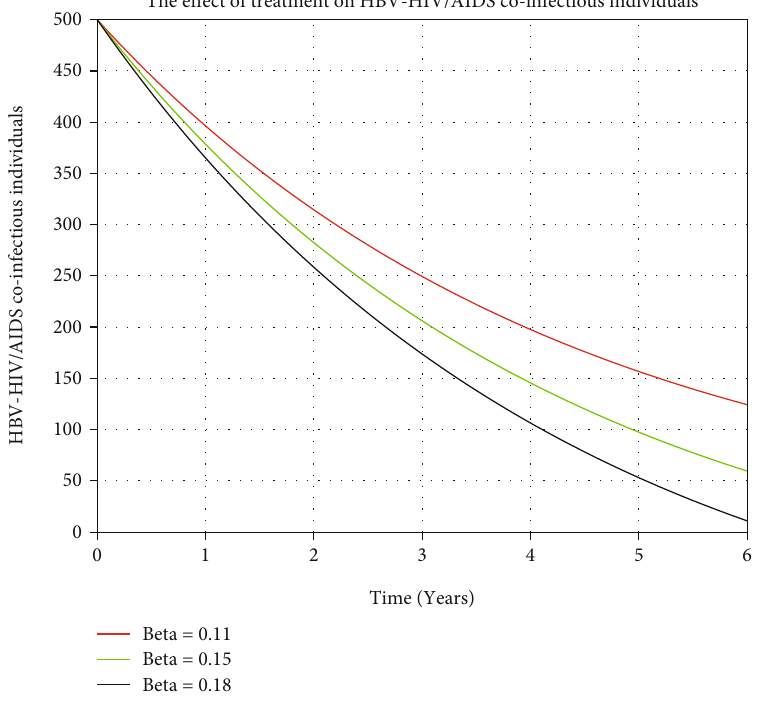
Figure 12: E ff ect of varying treatment rate on HBV-HIV/AIDS coinfectious individuals simultaneously.